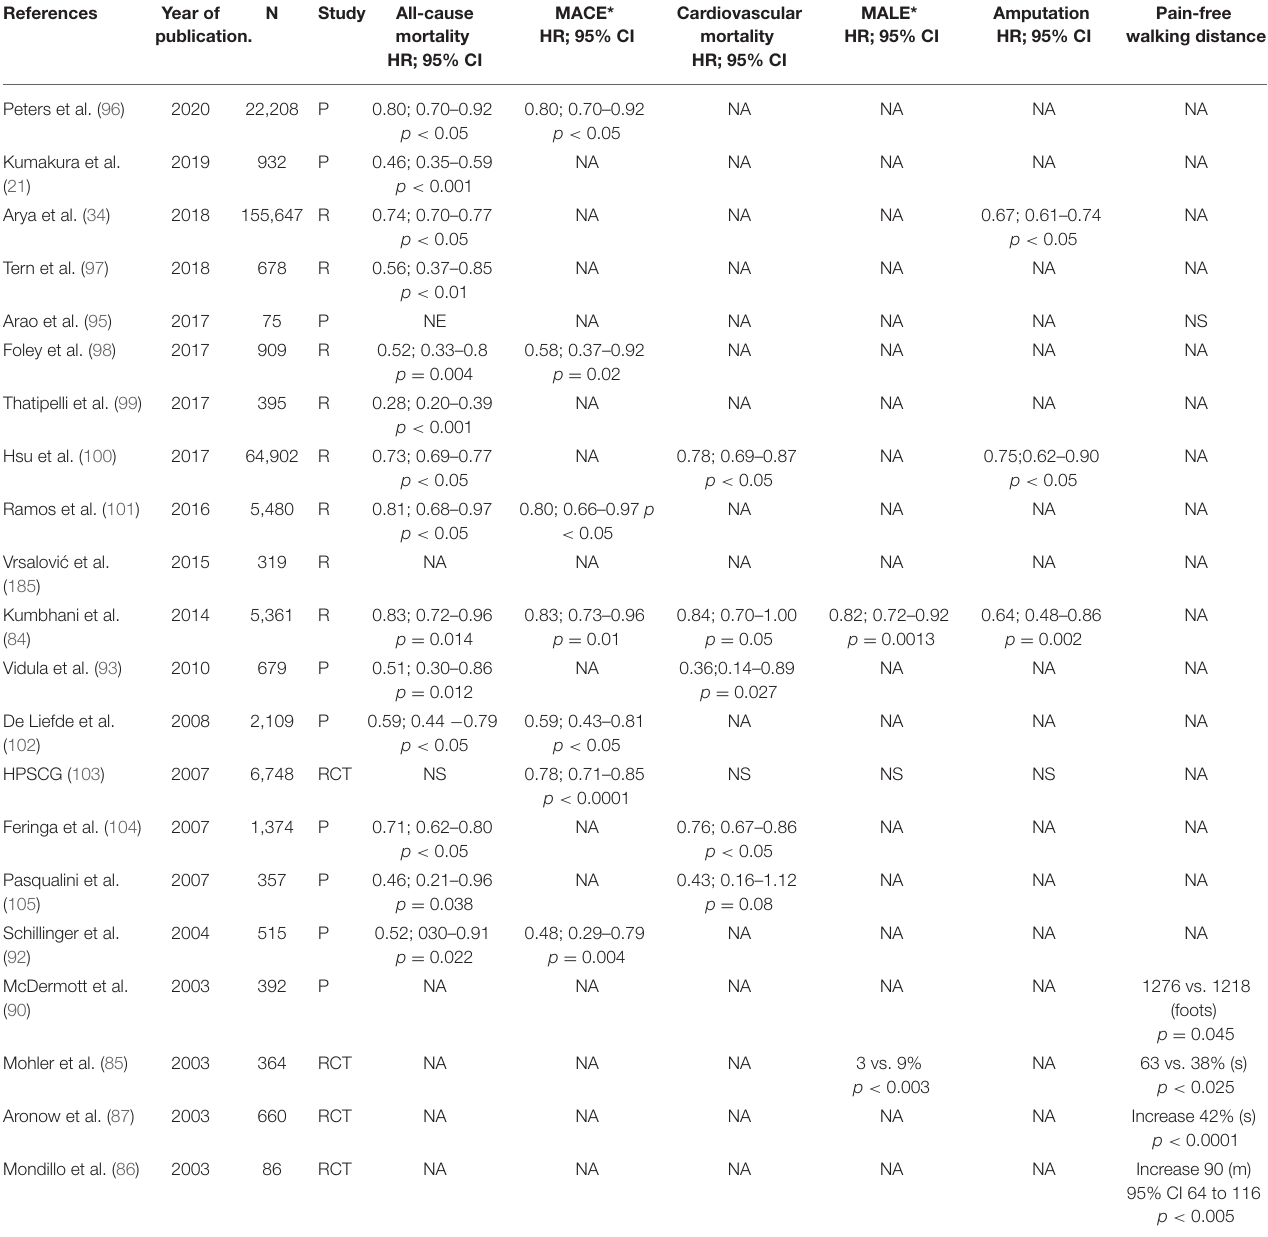
TABLE 1 | Benefits of statins in patients with early stages of PAD (asymptomatic or symptomatic